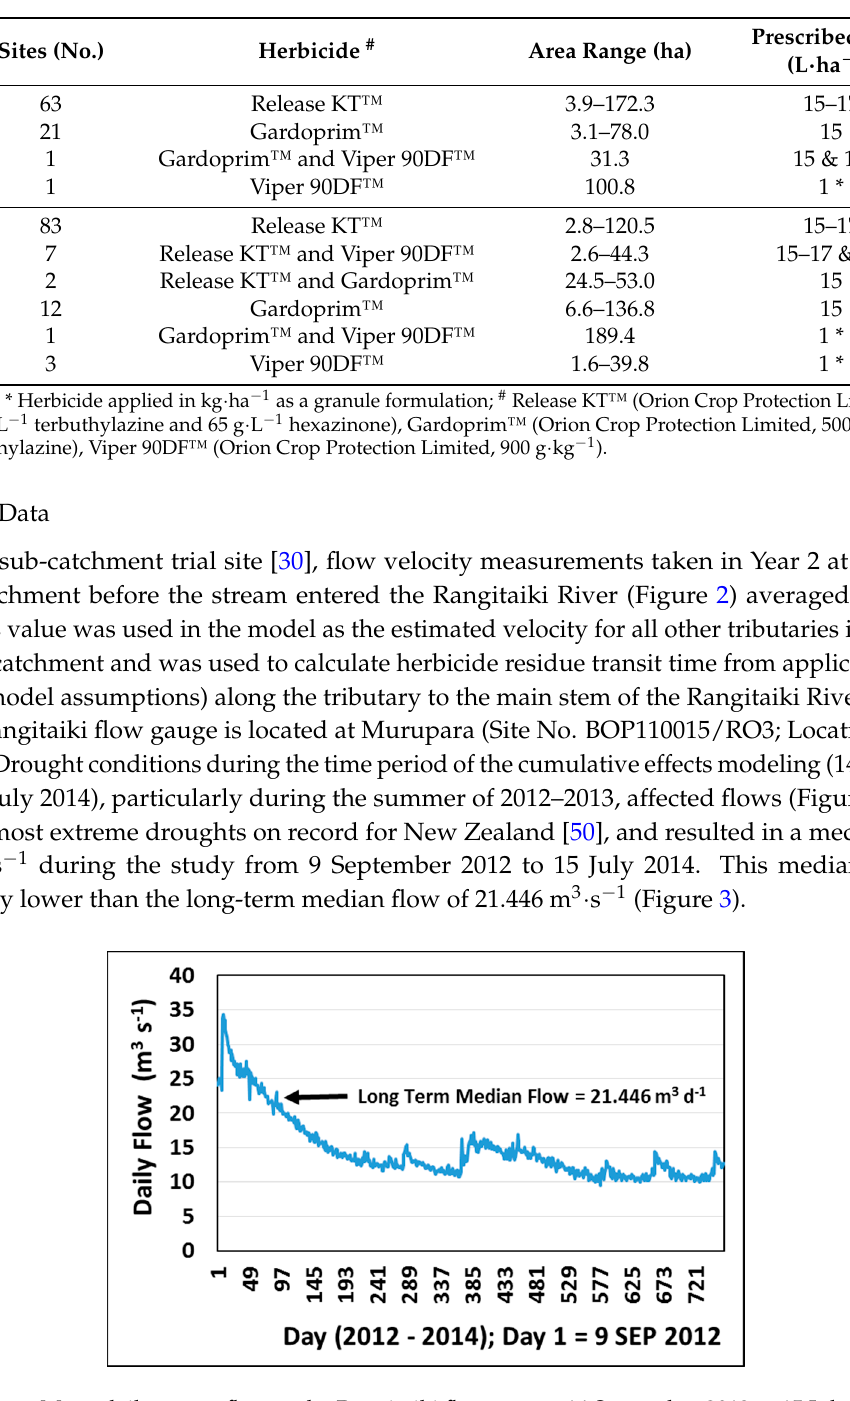
Figure 3. Mean daily streamflow at the Rangitaiki flow gauge, 14 September 2012 to 15 July 2014.